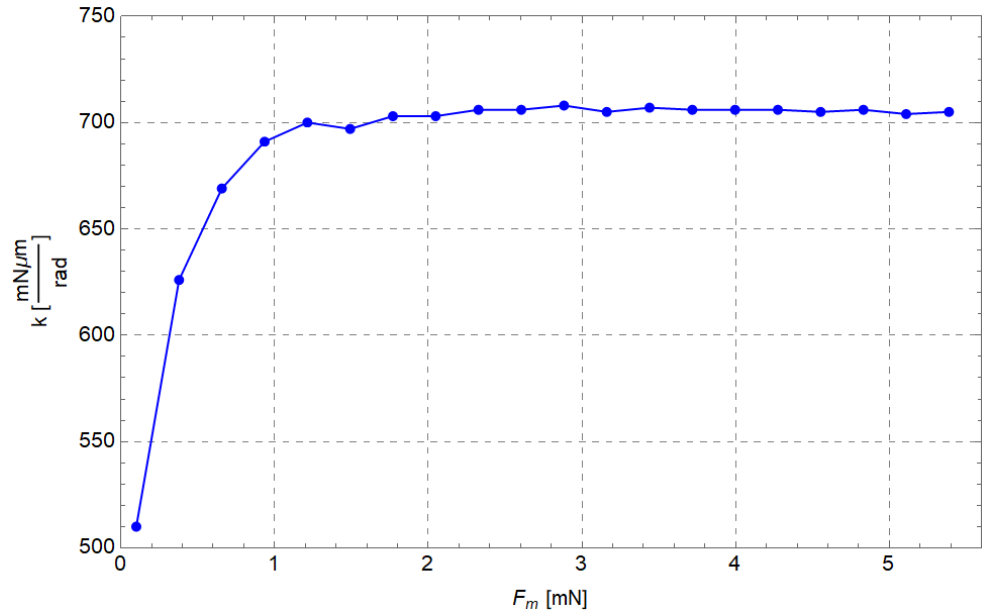
Figure 20. Curved beam stiffness vs input force obtained from FEA simulations.